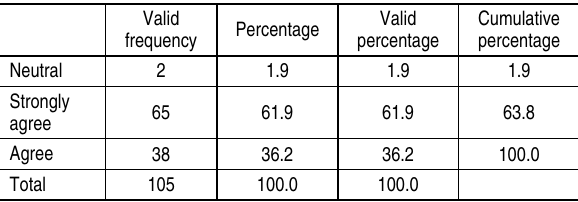
Table 20. Importance of